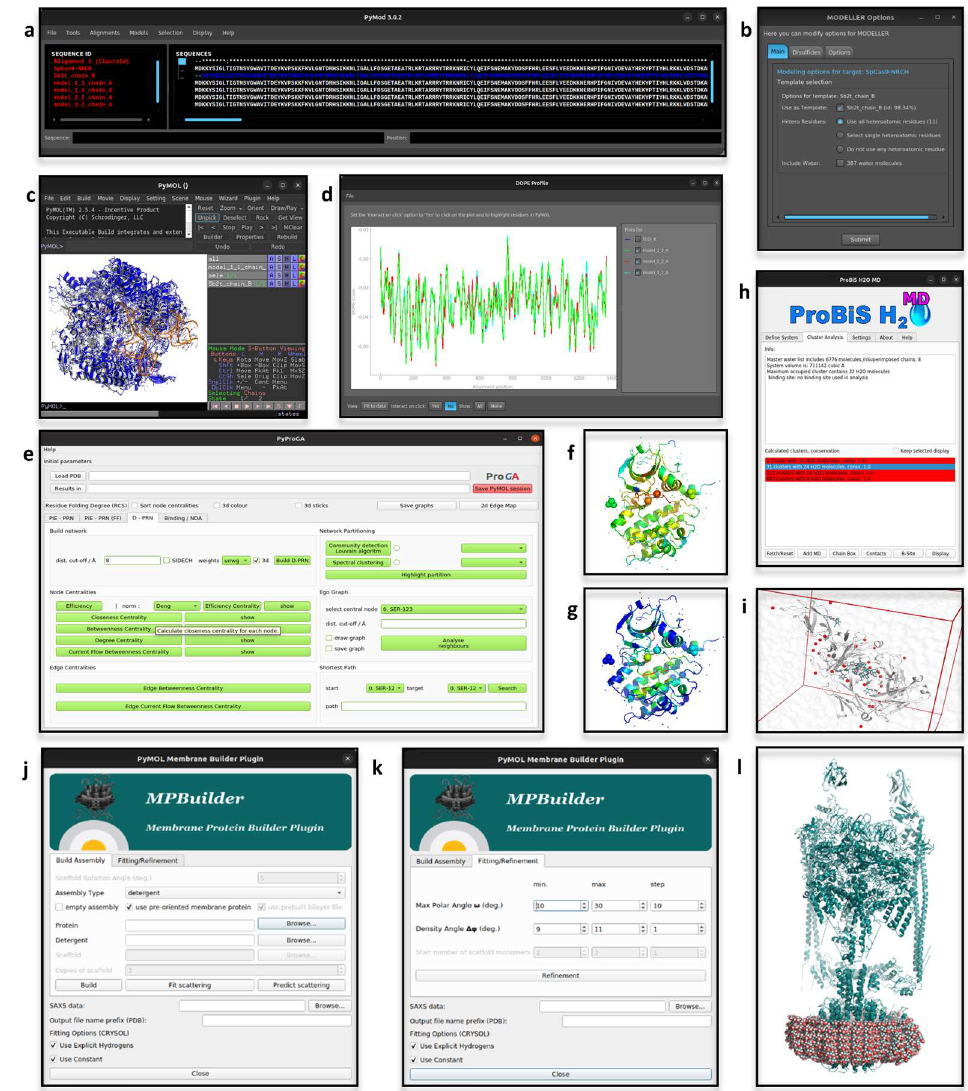
Figure 1. ( a–d ) Appearance of PyMod and PyMOL when running a template-based protein structure prediction. In this example, the ‘fasta’ file of the sequence to be modeled was directly opened in PyMod, while the template structure (PDB-ID: 5B2T [35]) was imported from PyMOL. The sequences of interest are visualized in the dedicated interactive window of PyMod, within which the analyses can be run ( a ). ( b ) PyMod window to set-up the parameters to run MODELLER [26] (e.g., how to consider heteroatoms, water molecules or disulfide bridges during calculations). ( c ) Visualization of the modeled structures in PyMOL workspace. ( d ) PyMod window for visualizing plots of the quality assessment [28]. ( e ) Appearance of the pyProGA window, from which the parameters for D-PRN analyses can be set-up. In this example, pyProGA was used to compute two different measurements on a protein (PDB-ID: 1OL5 [36]), which was directly loaded from PyMOL. ( f,g ) pyProGA processing of the proteins loaded in PyMOL according to the computed measures, which in this example were the ’Degree Centrality’ ( f ) and ’Betweenness Centrality’ ( g ). ( h ) Appearance of ProBiS H20 MD window for analyzing the results. Each identified cluster of conserved water molecules is identified in PyMOL as a red sphere ( i ). In this example the plugin was used to identify the conserved water molecules from molecular dynamics (MD) trajectories of a globular protein in water (the input files, a topology and a trajectory file, are provided by the ProBiS web-site (http://insilab.org/probis-h2o-md; accessed on 14 October 2022)). ( j , k ) Appearance of ‘Build Assembly’ and ‘Fitting/Refinement’